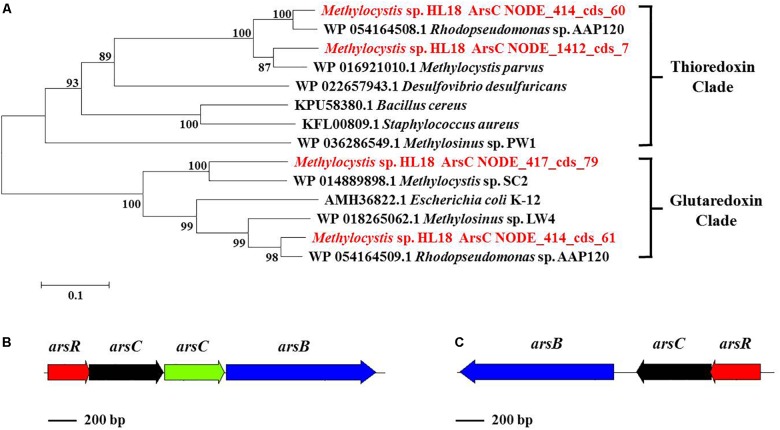
(A) Phylogenetic tree of ArsC based on amino acid sequences, (B)
ars operon containing four genes (arsR, arsC, arsC, and arsB) and (C) another ars operon containing three genes (arsR, arsC, and arsB). ArsC sequences recovered in this study from the metagenome were in red font and suffixed with their contig names. Numbers indicated the bootstrap support (1000 replicates).